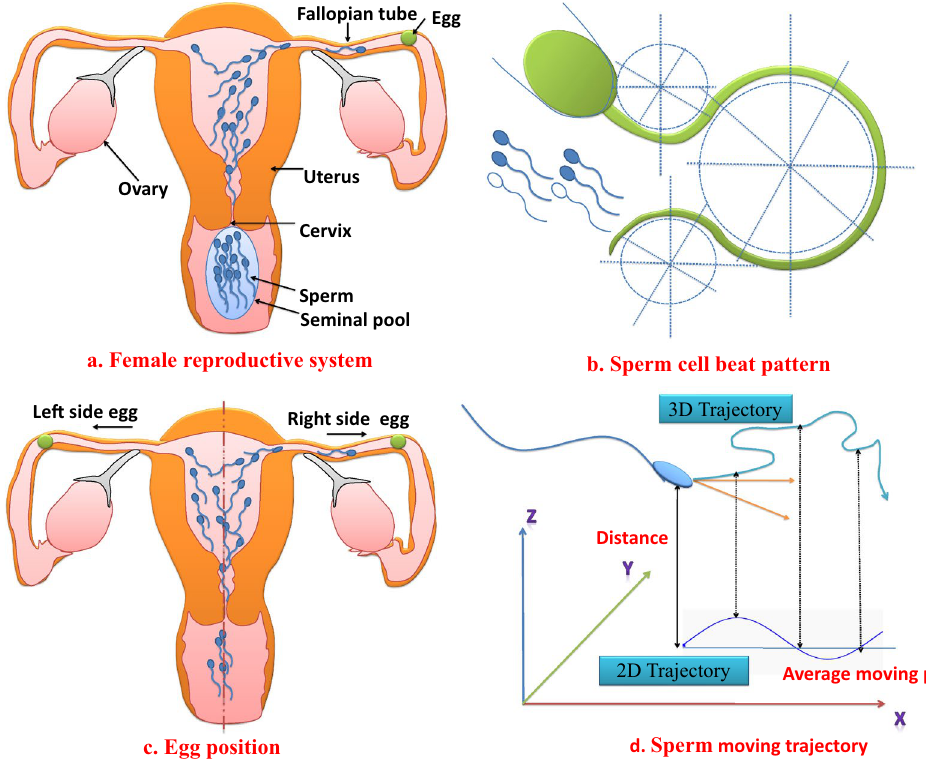
Figure 1. Human sperm movement. ( a ) Sperm cells movement in female reproductive system. ( b ) Sperm cells beat pattern. ( c ) Egg position in either side of fallopian tube. ( d ) Sperm cells moving